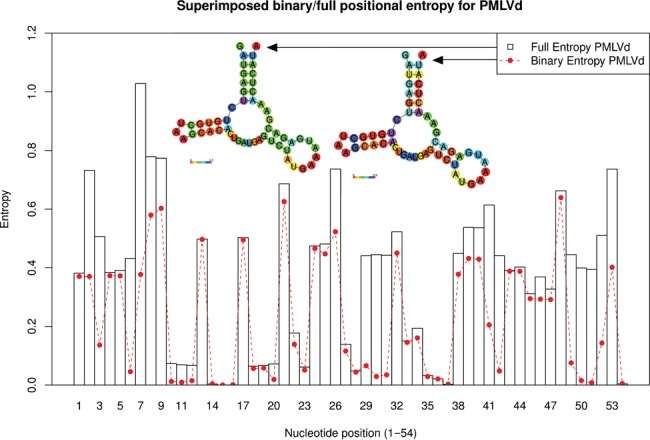
Binary and full structural positional entropy of hammerhead Peach Latent Mosaic Viroid (PLMVd) AJ005312.1/282-335. (Left) Full structural positional entropy H. (Right) Binary structural positional entropy Hb. Note that positions 50, 51 of have medium (full) entropy and high binary entropy, which indicates that these positions tend always to be base-paired in the low energy ensemble of structures, though with different base pairing partners. Note that the conserved region GUH in 6–8 has moderate to high entropy (G6: 0.62, U7: 1.48, H8: 1.12), GUC in 22–24 has low entropy (G22: 0.26, U23: 0.09, C24: 0.68), GAG in 27-29 has low entropy (binary entropy is very low) (G27: 0.12, A28: 0.04, G29: 0.07), while 44-49 has medium entropy. Left colored secondary structure figure created using relplot.pl from Vienna RNA Package (28); right upper colored secondary structure figure created by modifying code relplot.pl.